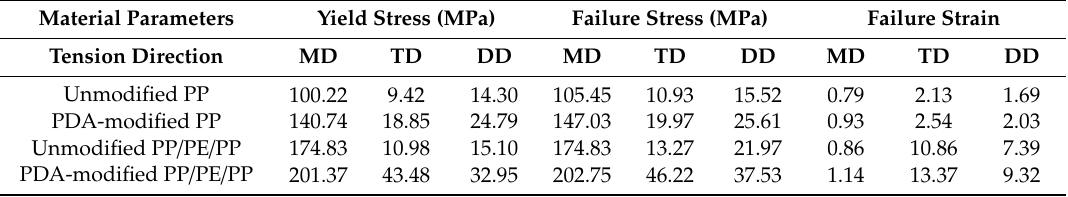
Table 3. Material parameters of unmodified and PDA-modified separators along TD, MD, and DD under strain rates 0.02 s − 1